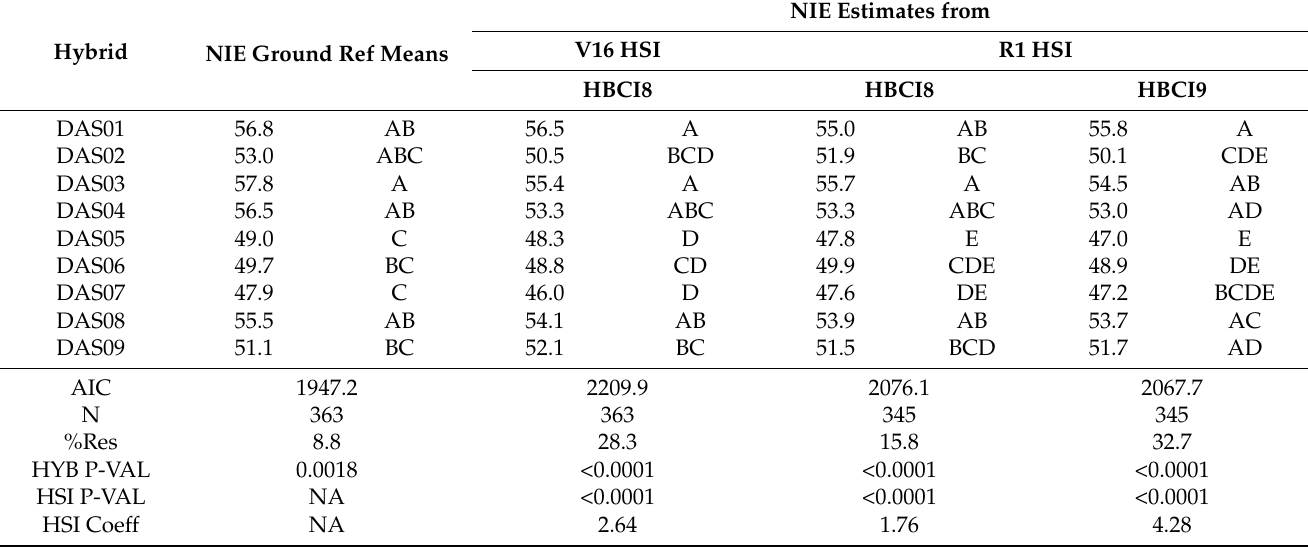
Table 9. NIE least square mean estimates (kg kg − 1 N) and fit statistics for various HSI-based models at the V16 or R1 maize development stage. Hybrid means with different letters are significantly